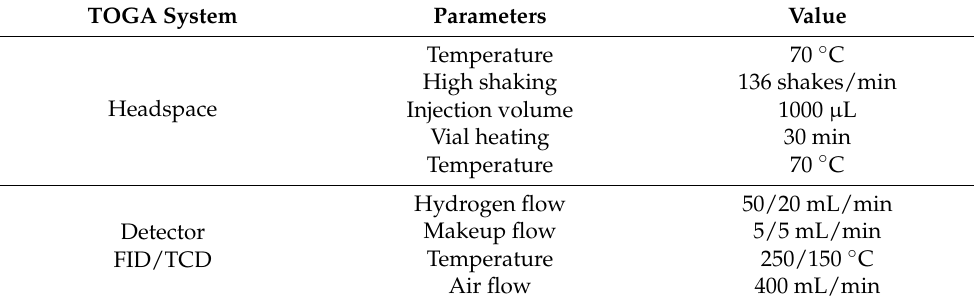
Table 1. Headspace and detectors parameters.